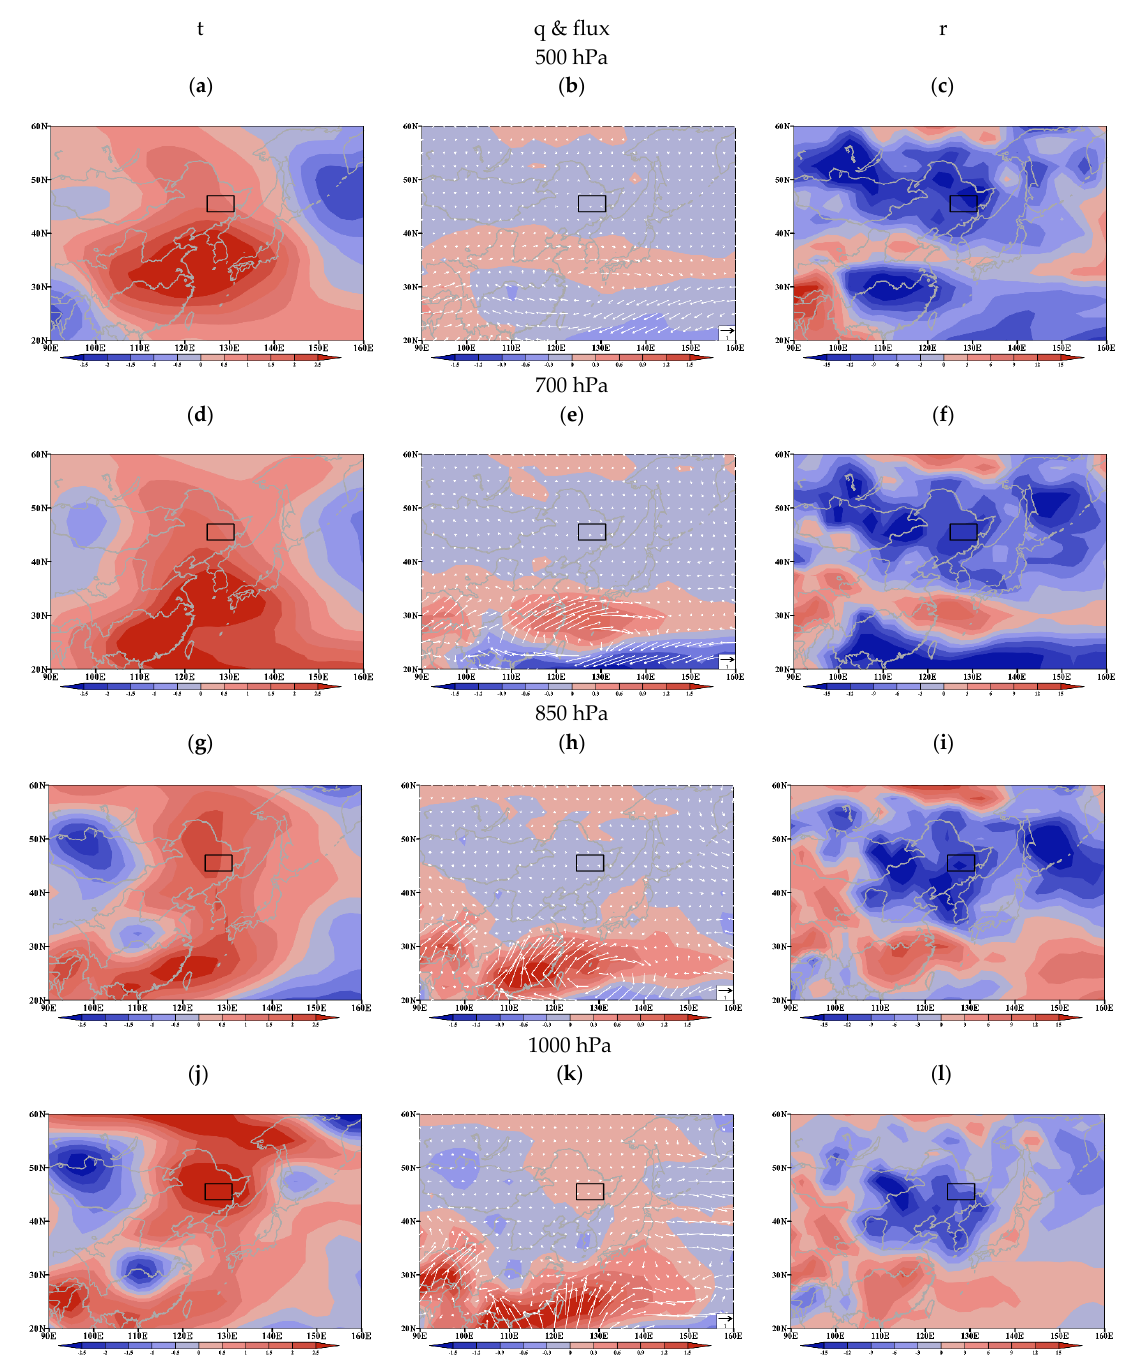
Figure 4. The anomalies in temperature (unit: °C), specific humidity (unit: g kg −1 ; shaded) and water vapor flux (unit: g kg −1 m s −1 ; vector), and relative humidity (unit: %) at ( a – c ) 500 hPa, ( d – f ) 700 hPa,